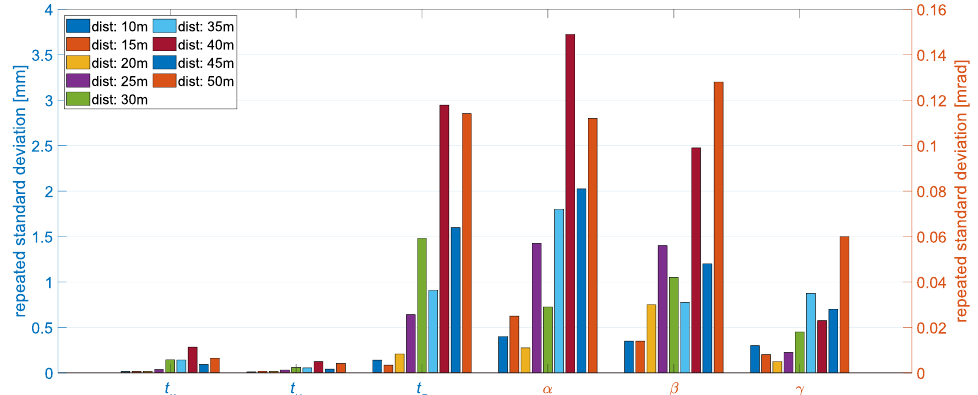
Figure 14. The systems precision is represented by the repeated standard deviations of the object pose from the test measurements at distances varying from 10m to 50m. Object orientation: